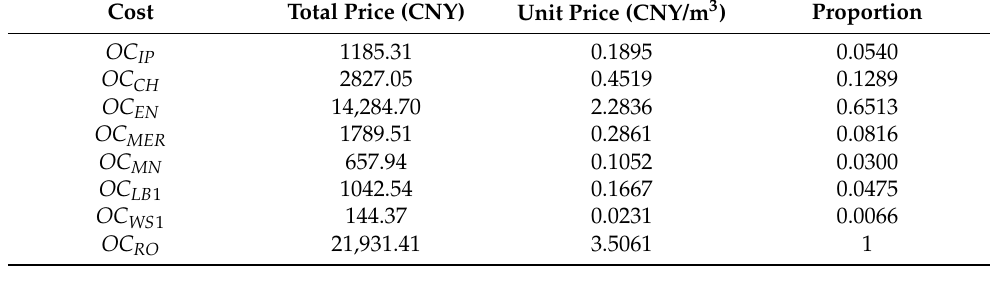
Table 2. SWRO system cost ratio table.